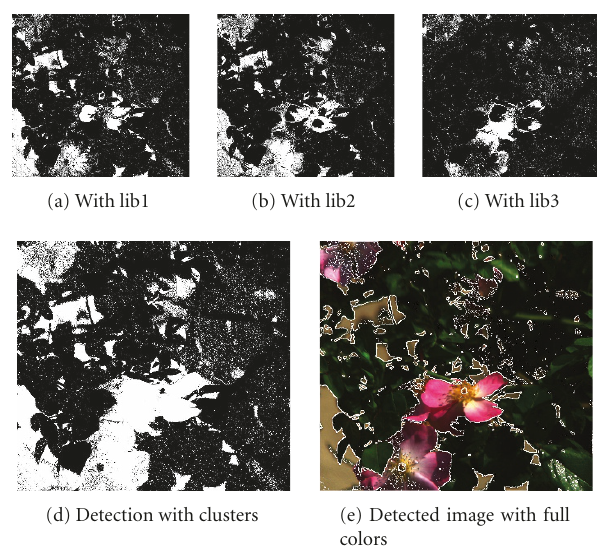
Figure 7: Relationship between the correlation values and percent- age of detected image ( P ) when clustered bands (27, 28, 29, 30) are used in the detection.